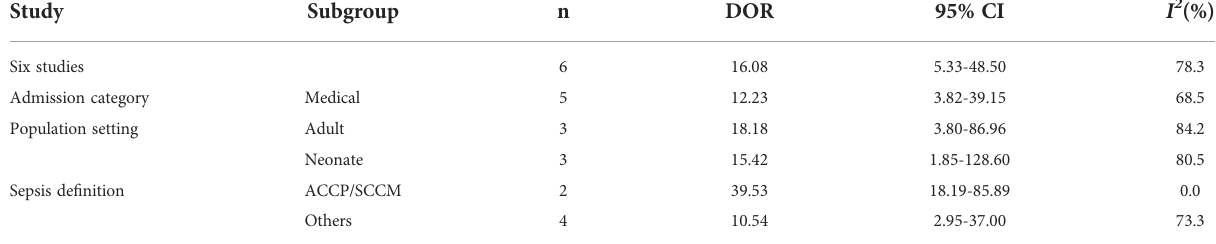
TABLE 2 Results of the subgroup